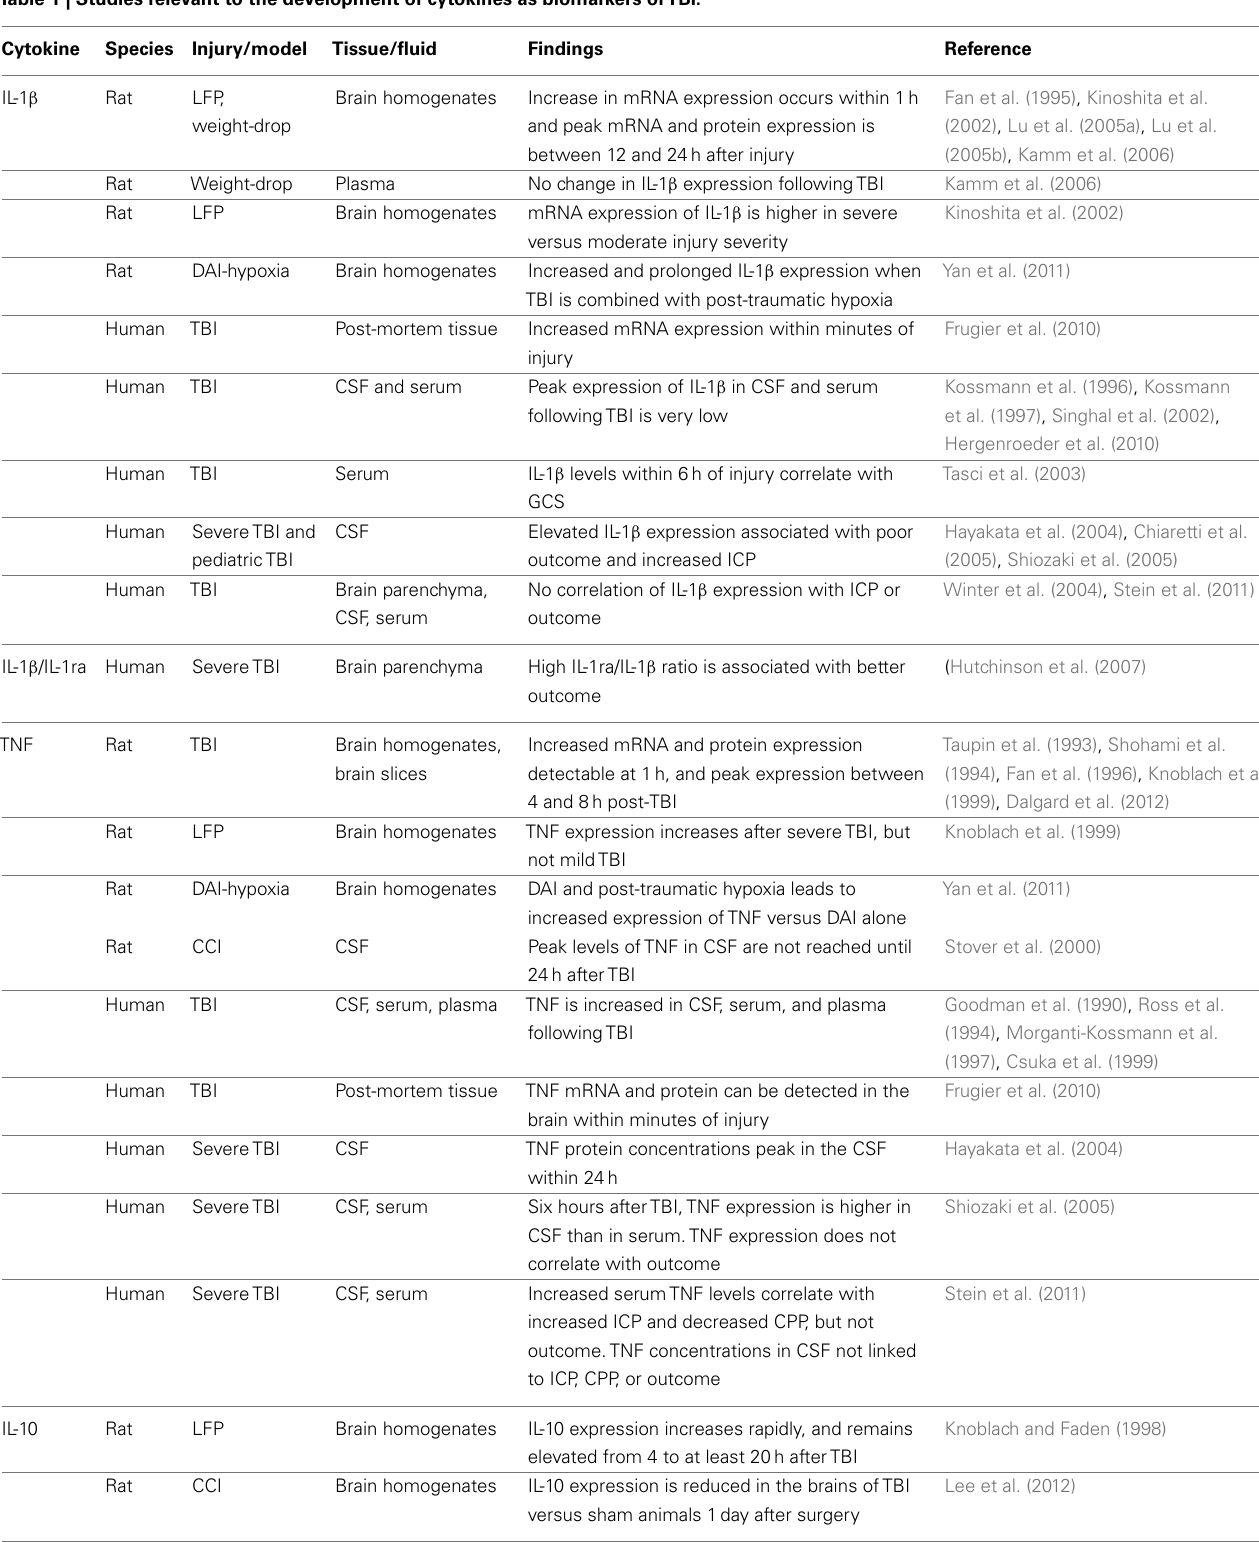
Table 1 | Studies relevant to the development of cytokines as biomarkers ofTBI. Cytokine Species Injury/model